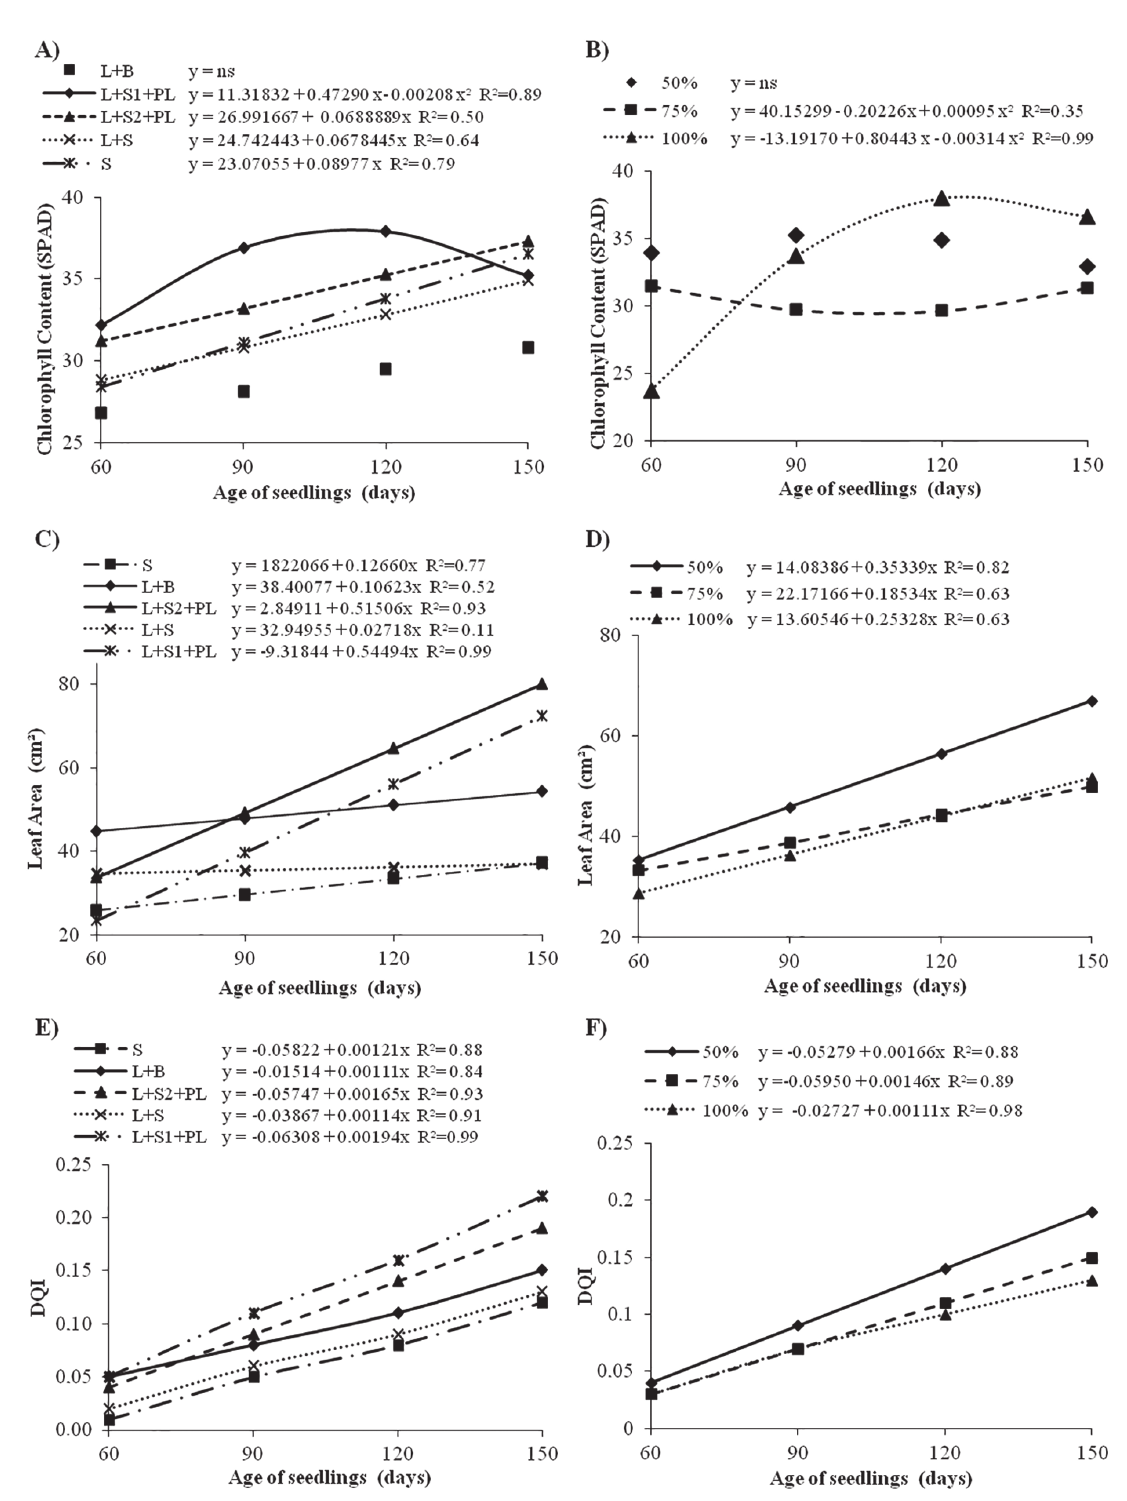
Figure 2 - Chlorophyll Content, Leaf Area and Dickson Quality Index in uvaia seedlings ( Eugenia pyriformis Cambess.) in substrates functions (a, c, e) and water holding capacity (b, d,